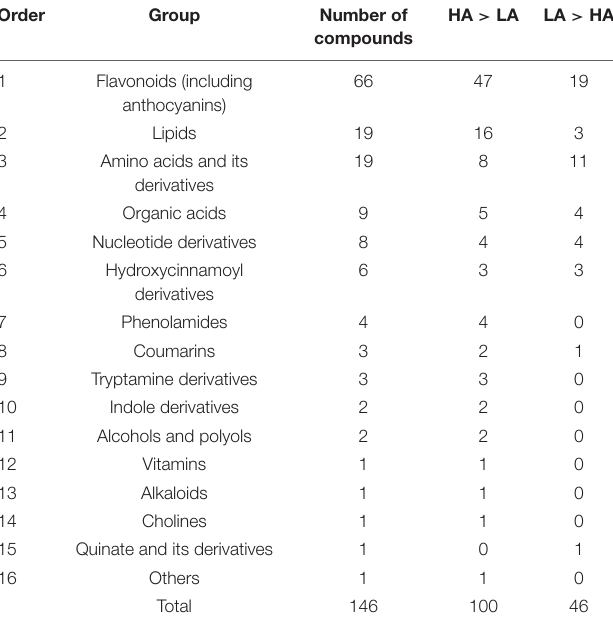
TABLE 1 | Metabolite accumulation in the leaves of Cyclocarya paliurus at low and high